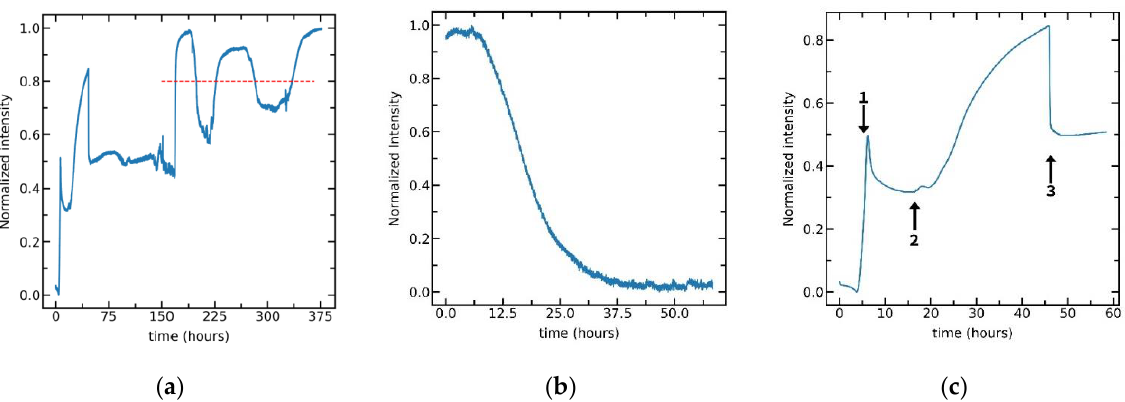
Figure 6. ( a ) Normalized reflected light intensity over the cure and the “wet/dry” cycles on the cement paste, sample B. ( b ) Wet cycle made one week later, on the same sample. ( c ) Normalized reflected light intensity during the first 60 h of the seven-day cure of sample B: (1) Hardening of cement, (2) possible water bleeding and (3) externally added water.